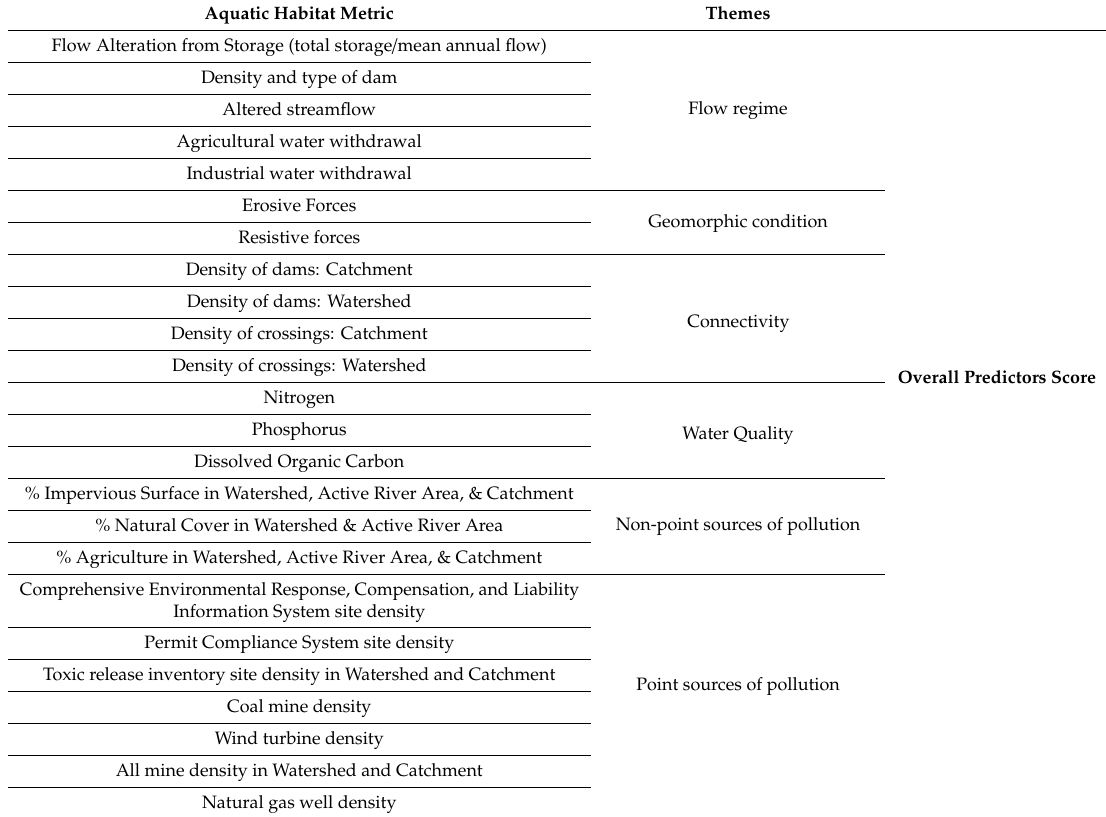
Table 1. List of final predictors used in boosted regression tree models and how each was grouped